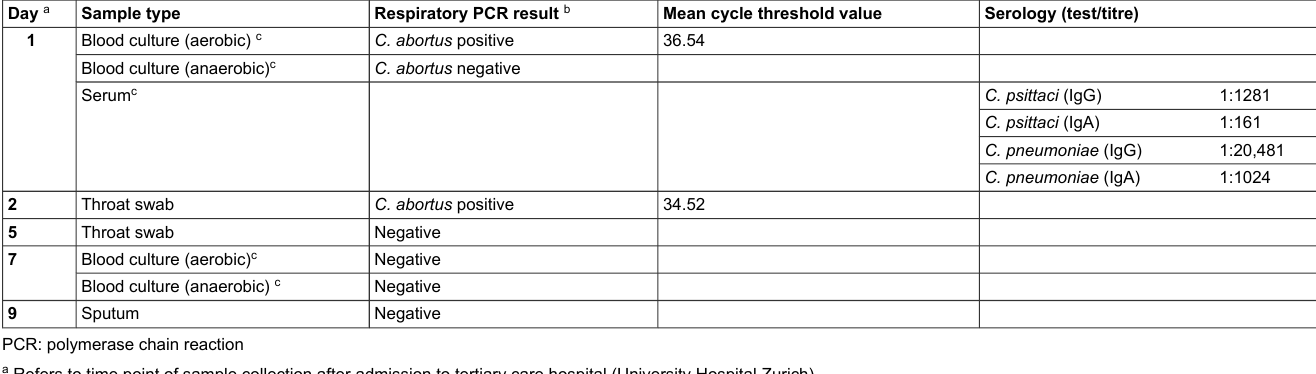
Table 4: Patient 2: PCR and serology findings related to Chlamydia abortus infection. Day